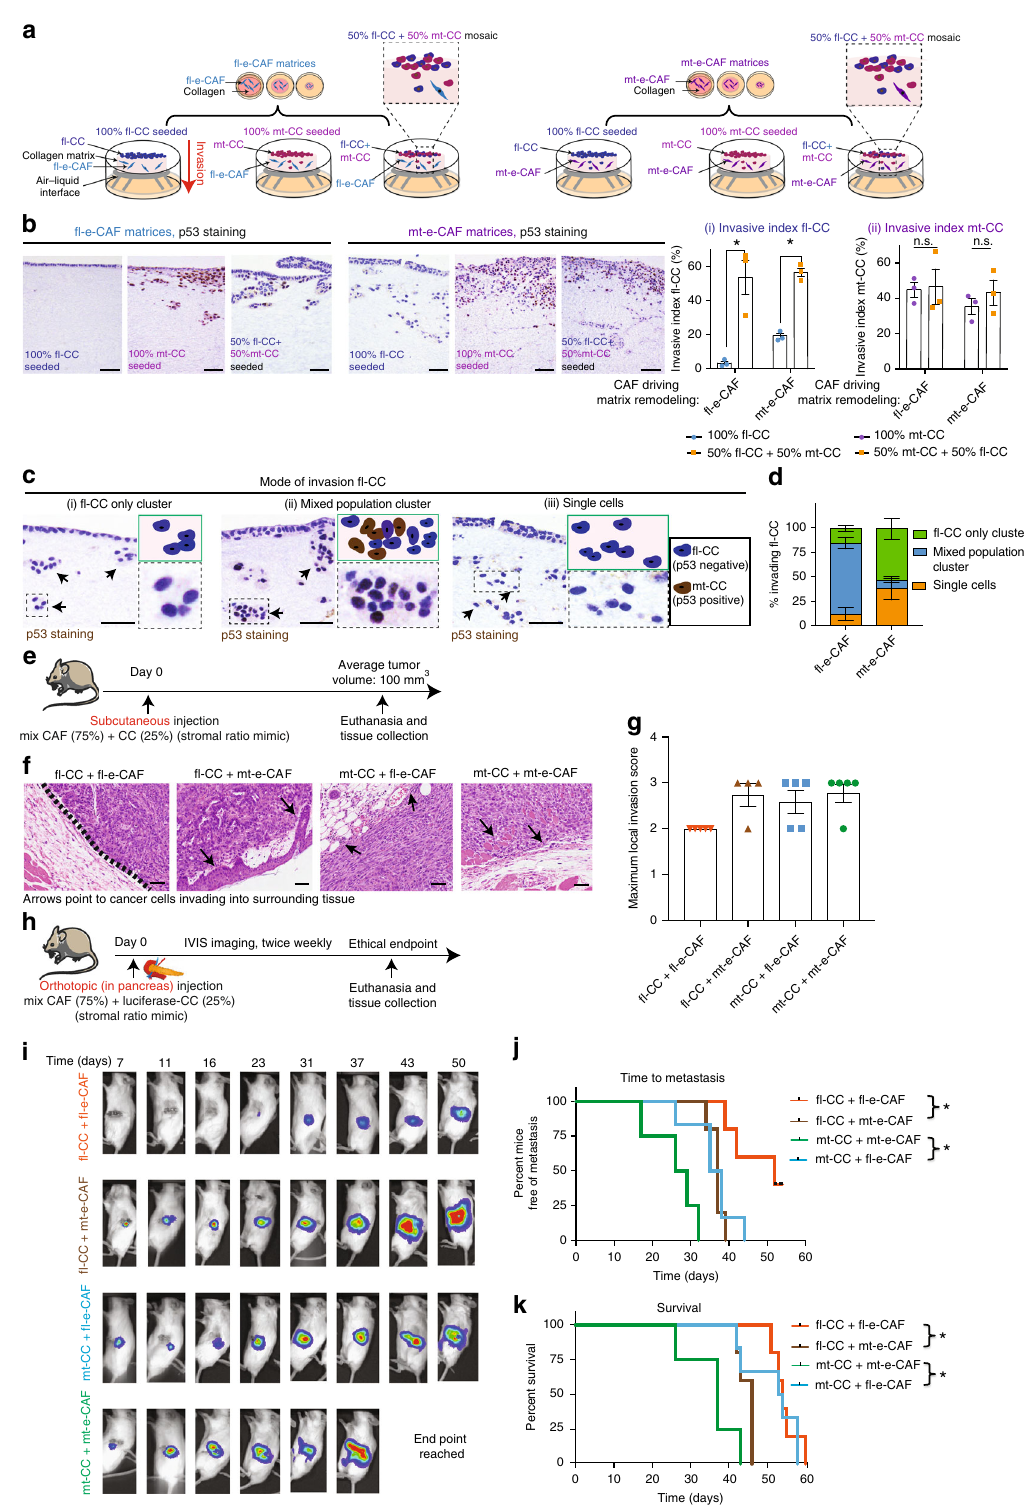
fl -CCs or mt-CCs with mt-e-CAFs KO HSPG2 orthotopically (Fig. 4g). We compared metastatic burden and survival to the original orthotopic model using mt-e-CAFs WT (Fig. 3h – k). This revealed that survival was enhanced and metastatic burden was reduced in the presence of mt-e-CAFs KO HSPG2 compared to mt-e-CAFs WT for both fl -CCs and mt-CCs, with a more pronounced effect for mt-CCs (Fig. 4g – i). Metastatic burden in NATURE COMMUNICATIONS| (2019) 10:3637